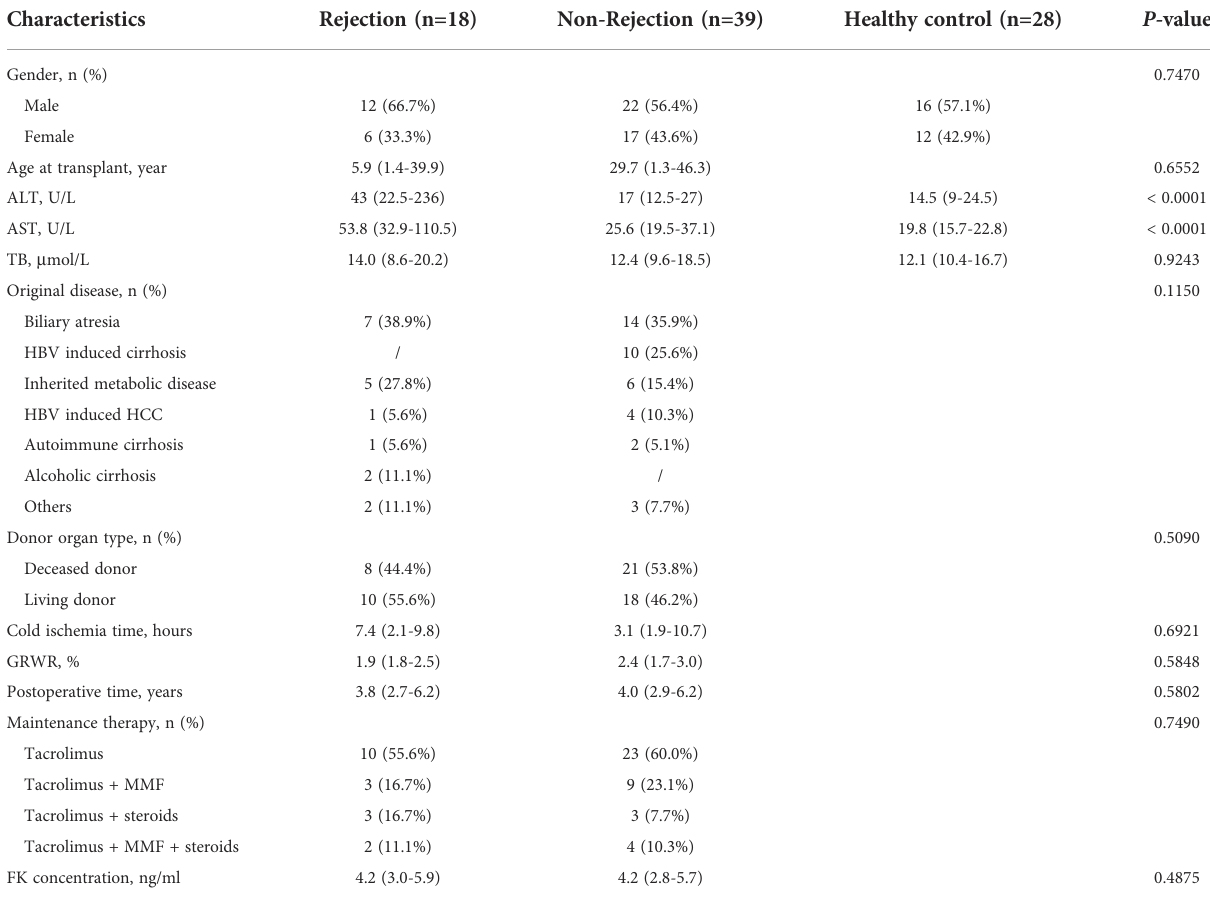
TABLE 1 Demographic and clinical characteristics of the participants.